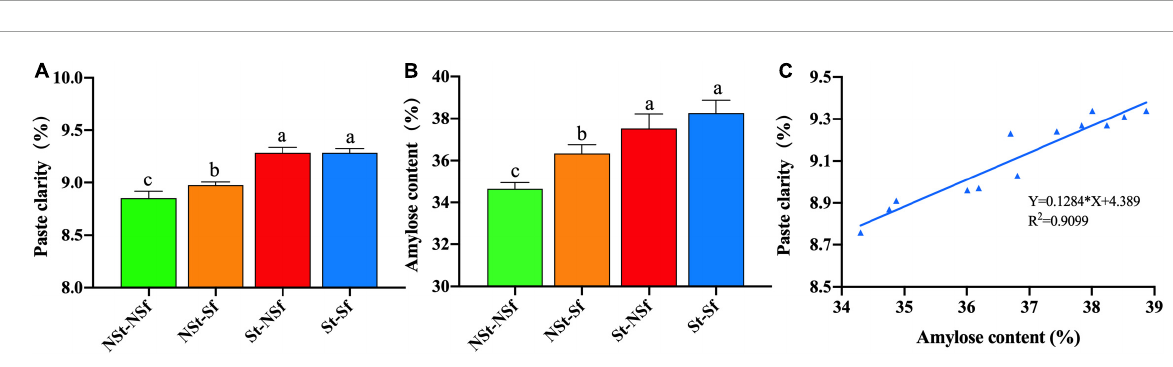
FIGURE2 Effects of steaming and sulfur fumigation on paste transparency (A) , amylose content (B) , and the correlation between paste transparency and amylose content (C) of Gastrodia elata